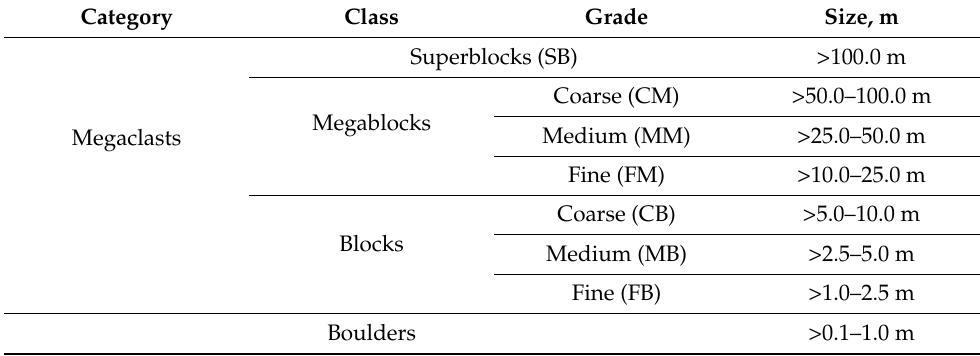
Table 1. The Megaclast Classification Proposed by Bruno and Ruban [11].